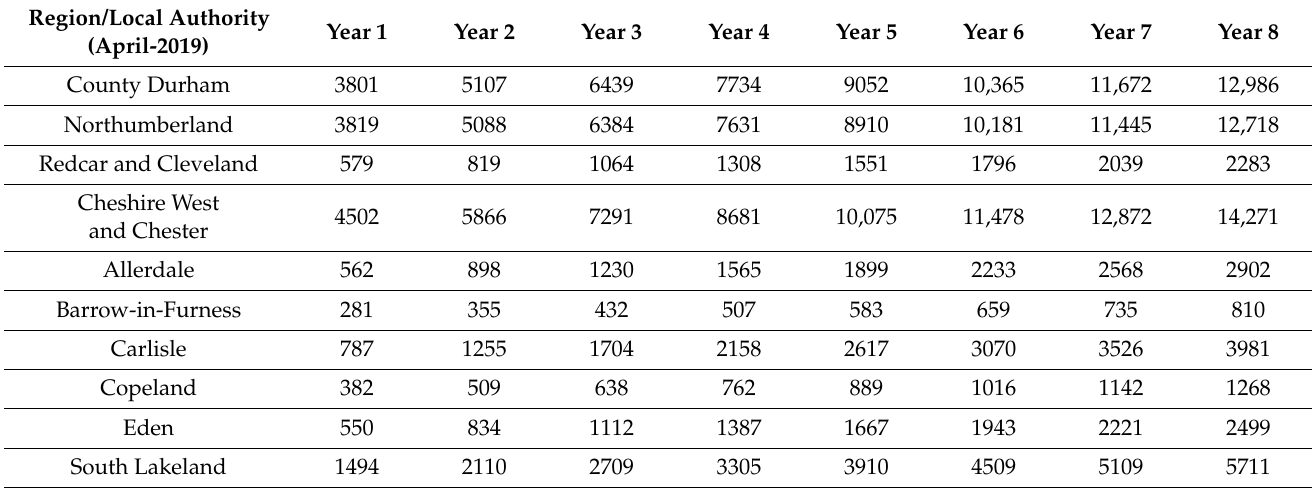
Table 14. Selection of E d data (kWh).